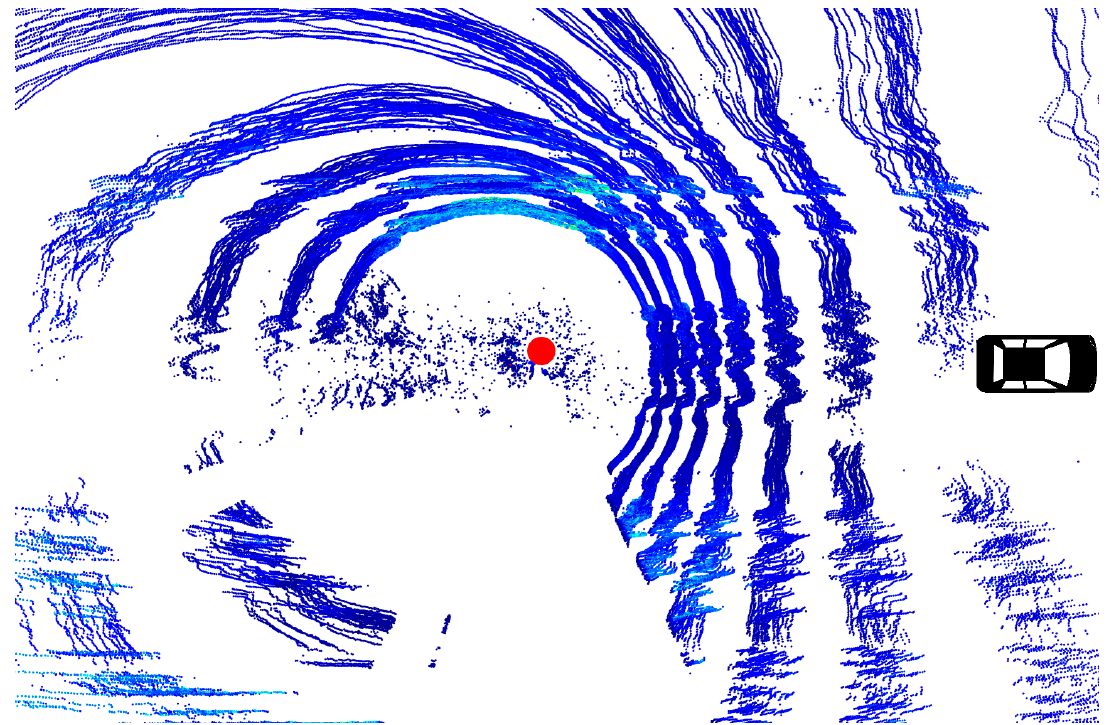
Figure 11. A Velodyne point cloud when driving behind a leading vehicle.